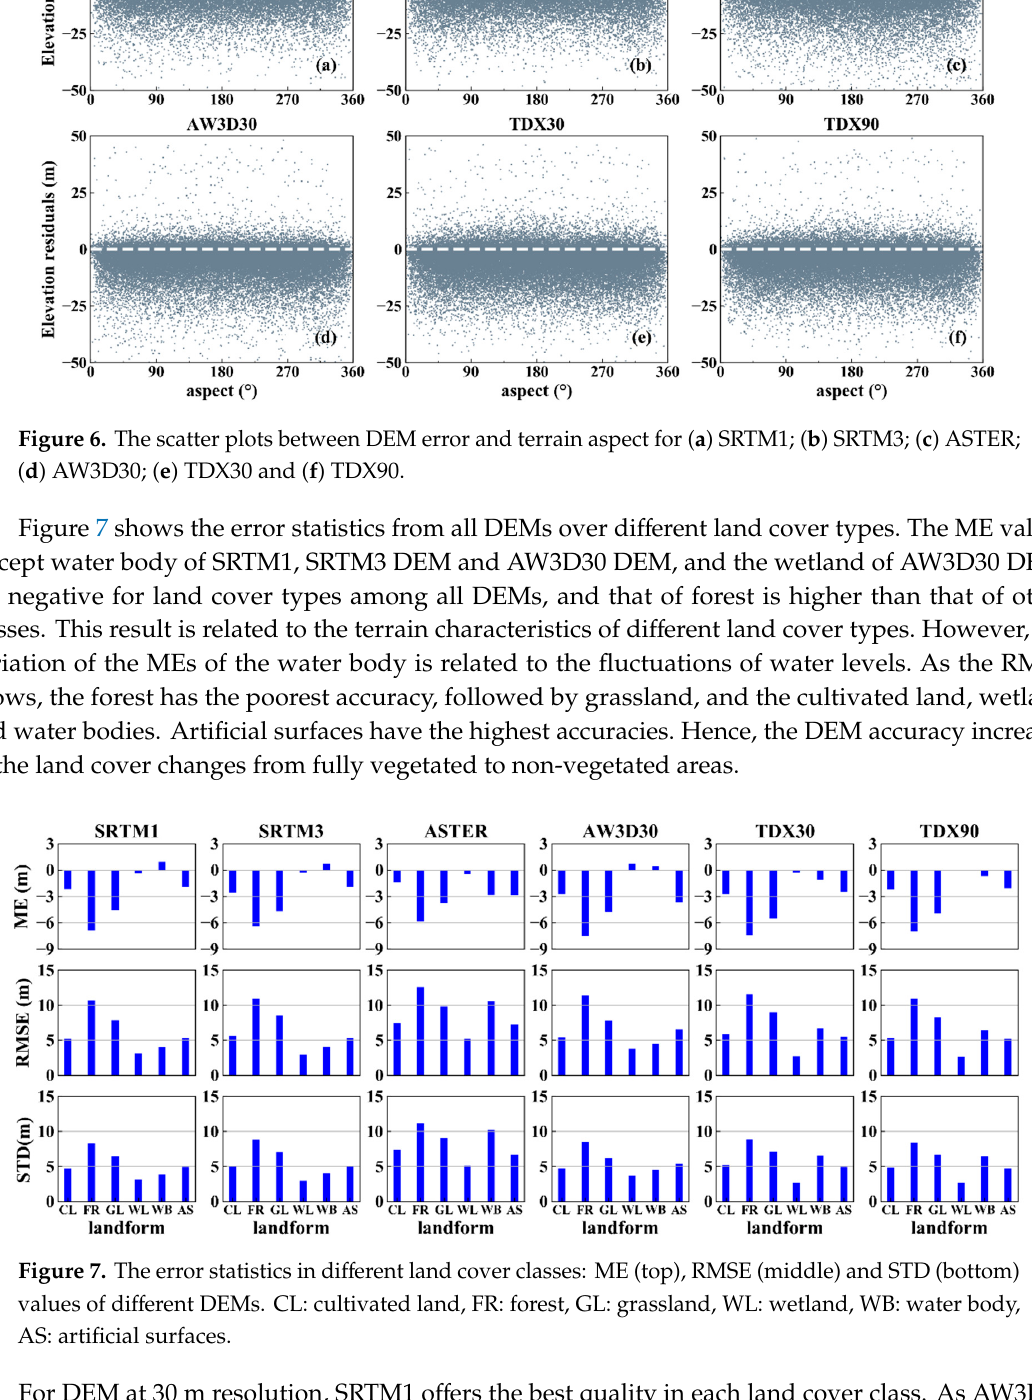
Figure 5. DEM error statistics of different slopes; ME (top), RMSE (middle) and STD (bottom). (1: 0–